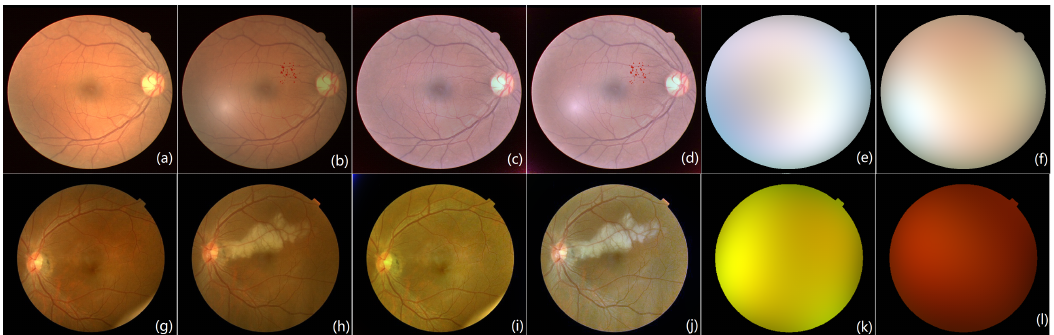
Figure 4. Fundus image pairs with a different size of lesions. ( a ) Reference image from DRIVE; ( b ) current image attached with the small noise patch; ( c ) corrected images of ( a ) by IRHSF; ( d ) cor- rected images of ( b ) by IRHSF; ( e ) illumination model of ( a ); ( f ) illumination model of ( b ). ( g , h ) are from Xinhua Hospital in Shanghai. ( g ) Reference image, ( h ) current image, ( i ) corrected images of ( g ) by IRHSF, ( j ) corrected images of ( h ) by IRHSF, ( k ) illumination model of ( g ), ( l ) illumination model of ( h